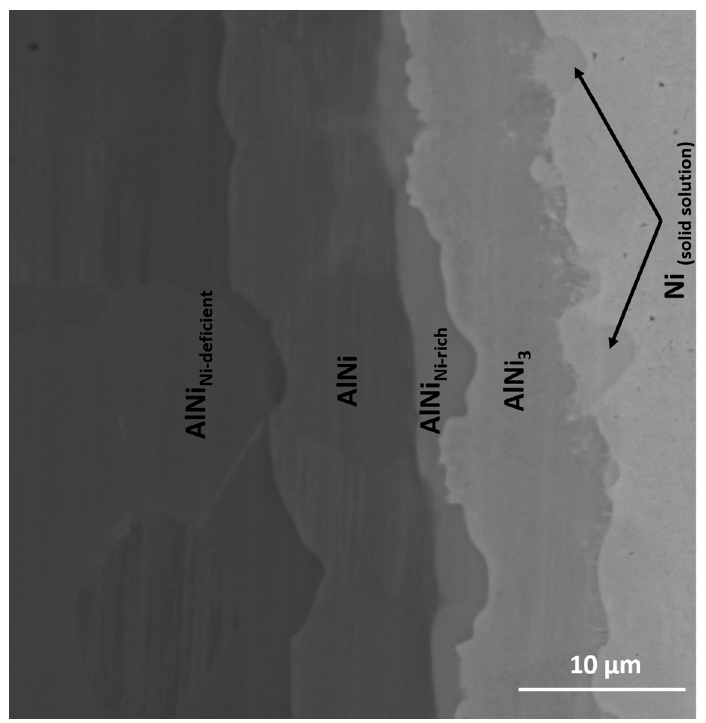
Figure 9. SEM micrograph in BSE mode of the intermetallic phases formed in the solid state after 20 h at 720 °C.